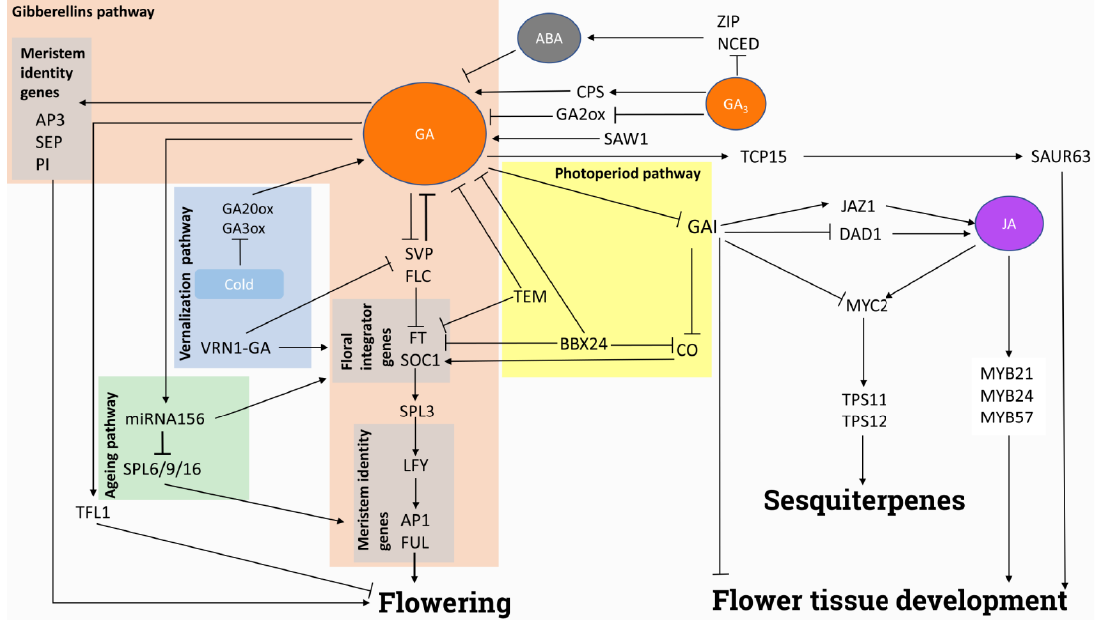
Figure 2. Schematic representation of the GA-related signaling involved in flowering and the development of the flower tissues. Arrows indicate activation and blunt-end lines indicate repression or inhibition. Orange box represents the GA flowering pathway, the blue box the vernalization flowering pathway, the yellow box the photoperiod flowering pathway and green box the aging flowering pathway. Grey boxes represent meristem identity genes and floral integrator genes. See text for details and references. ABA: abscisic acid, AP1/3: apetala 1/3, BBX24: B-box domain protein